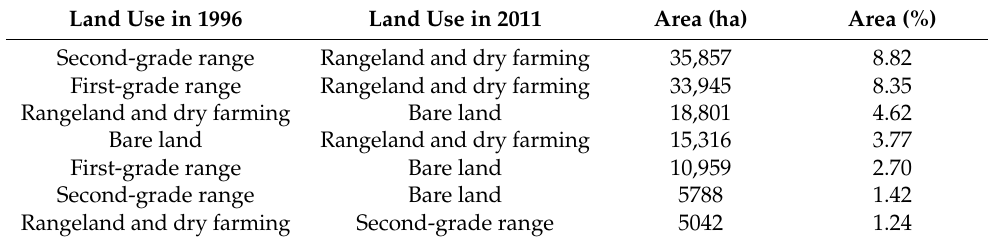
Table 5. Main changes in land use between 1996 and 2011.